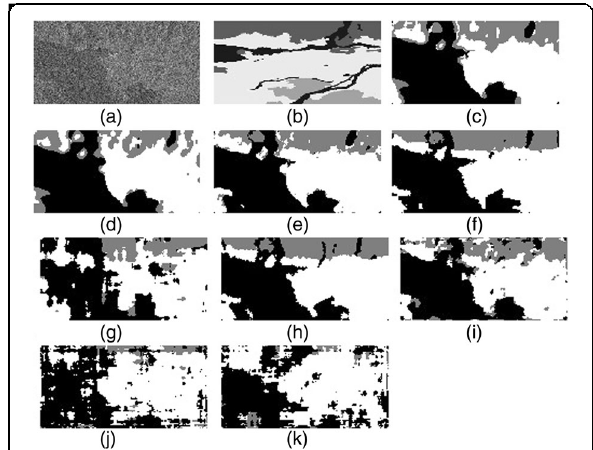
Fig. 29 Segmentation results for Vancouver image. a Original image. b Hand-segmented image. c Gaussian features. d Rayleigh features. e Alpha-stable features. f Gaussian + contourlet features. g Rayleigh